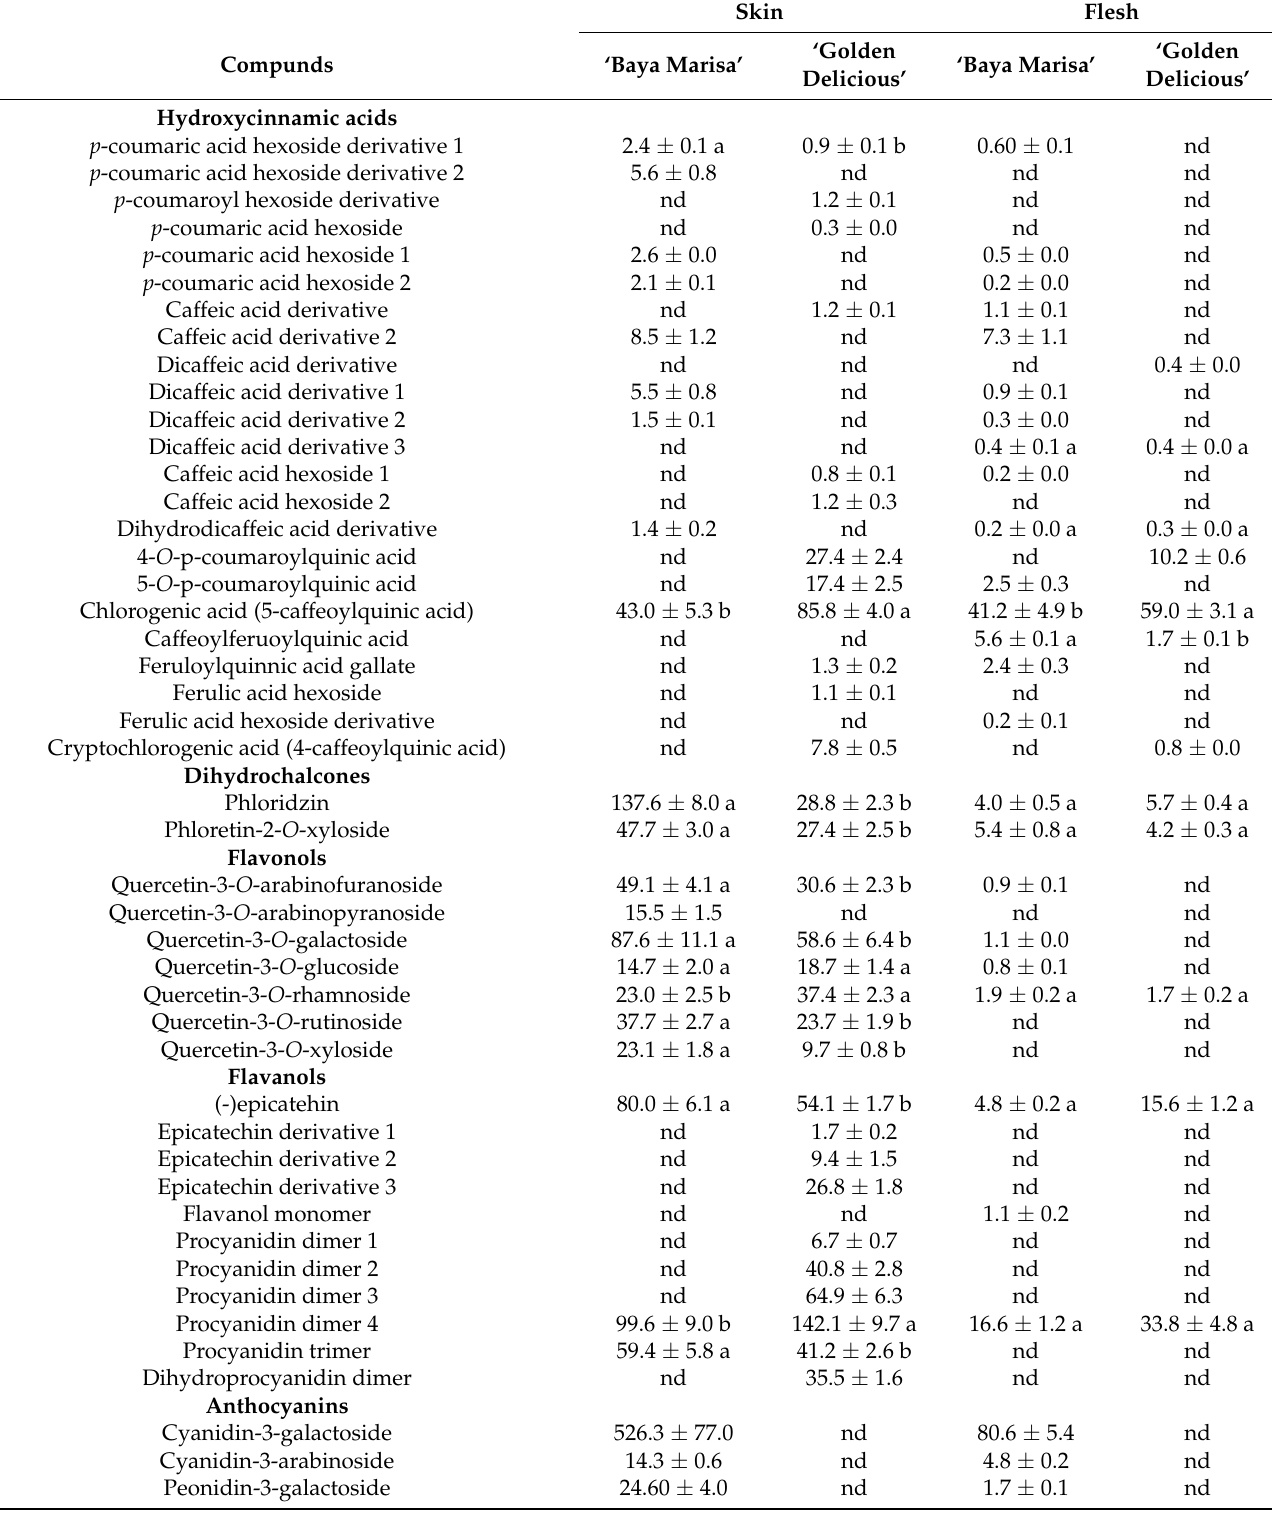
Table 3. Individual and total analyzed phenolic compounds (TAPC) in the skin and flesh of the two apple ( Malus domestica Borkh.) cultivars ‘Baya Marisa’ and ‘Golden Delicious’ (mean ± SE, in mg/kg